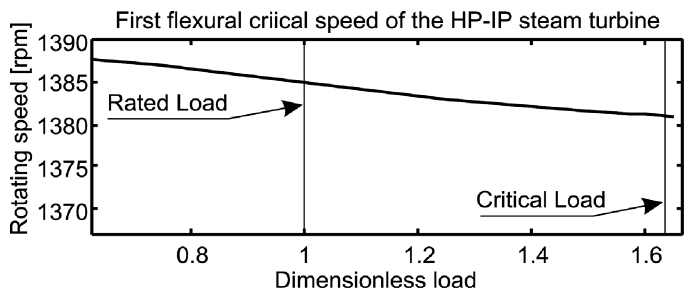
Fig. 19. First fl exural critical speed of the HP-IP turbine plotted vs. the dimensionless load.